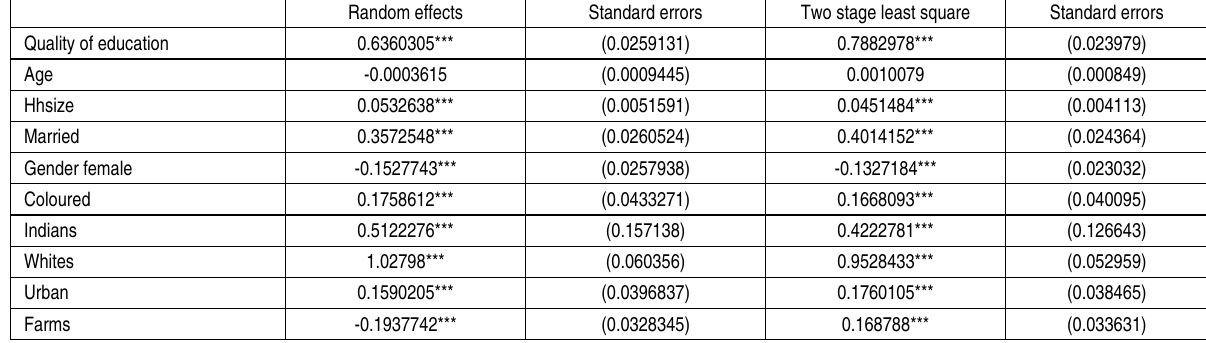
Table 1. Random effects and 2SLS estimates of the effect of quality of education on earnings in